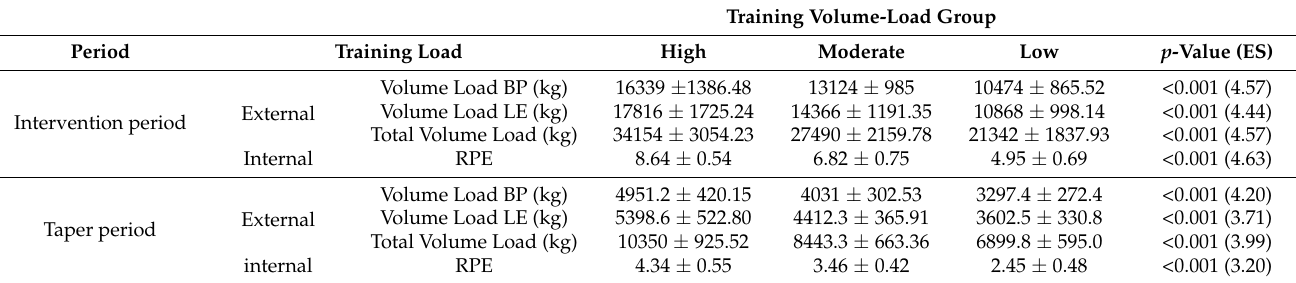
Table 3. Quantification of external and internal training load during the 9-week of MST. Training Volume-Load